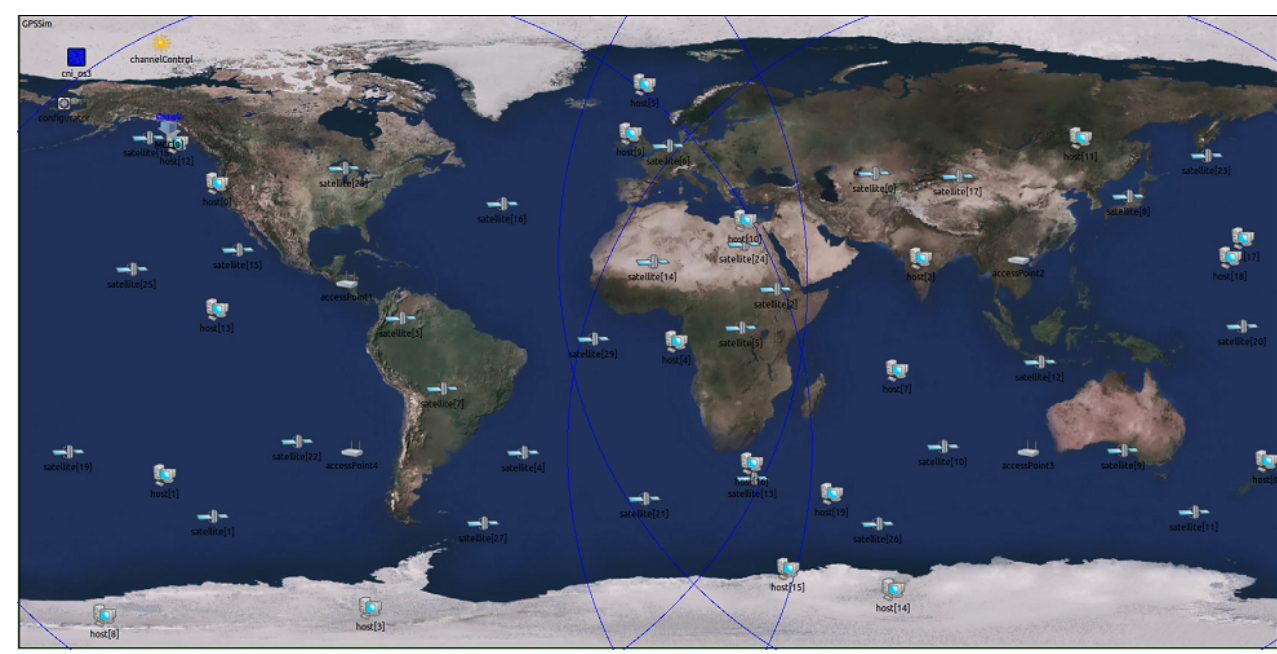
Figure 6. World map used for GPS